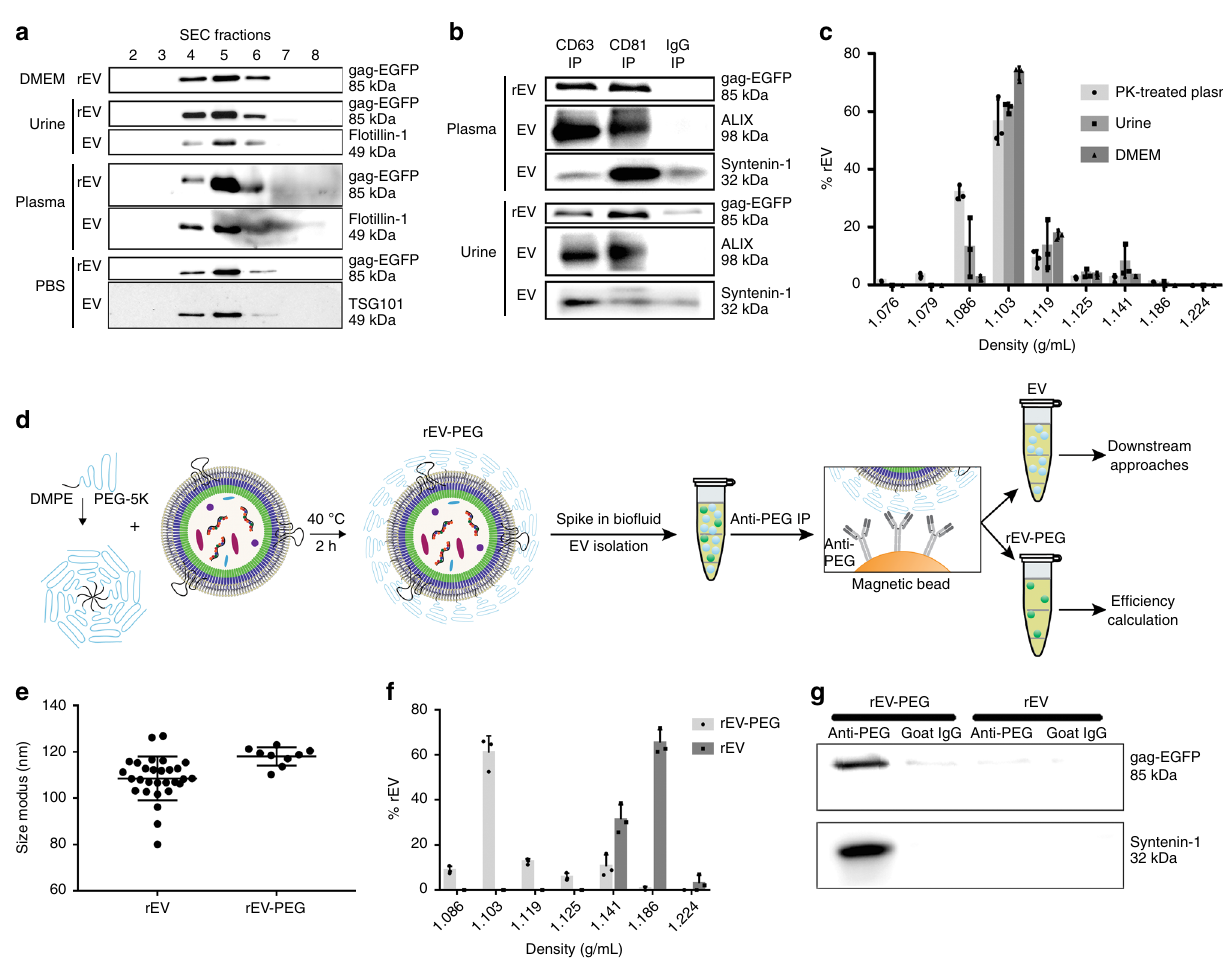
Fig. 4 rEV and rEV-PEG act as sample EV when spiked in multiple bio fl uids. a Western blot analysis for EGFP, fl otillin-1 and TSG101 of size exclusion chromatography (SEC) fractions from DMEM, urine, plasma and PBS (containing EV from MCF7 breast cancer cells) spiked or not with rEV. rEV is indicative of rEV spike; EV is indicative of sample EV (i.e. non-spiked bio fl uid). b Western blot analysis for EGFP, ALIX and syntenin-1 of plasma and urine spiked or not with rEV and immune precipitated using anti-CD81, anti-CD63 or non-speci fi c goat IgG coated magnetic beads (IP). rEV is indicative of rEV spike; EV is indicative of sample EV (i.e. non-spiked bio fl uid). c Density distribution of rEV spiked in urine, DMEM and proteinase K (PK) treated plasma, obtained by ODG centrifugation followed by fNTA measurement of ODG fractions ( n = 3). d Schematic of rEV post-insertion PEGylation to make rEV compatible with multiple bio fl uids and to allow segregation of rEV from sample EV prior to downstream analysis of sample EV. e Size distribution of rEV and rEV-PEG measured by fNTA ( n > 9). f Density distribution of rEV-PEG and rEV spiked in plasma, obtained by ODG centrifugation followed by fNTA measurement of ODG fractions ( n = 3). g Western blot analysis for EGFP and syntenin-1 of immune precipitated rEV and rEV-PEG in PBS with anti-PEG or non-speci fi c goat IgG coated magnetic beads (image representative of two independent experiments). Data in c , e , f are presented as (mean, SD). Source data are provided as a source data fi